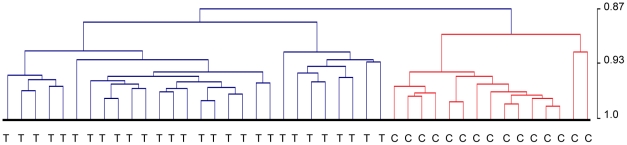
Dendogram from unsupervised hierarchical clustering.Including the 43 samples selected for differential gene expression analysis and all 12579 genes detected in these samples. Control samples are denoted by C and tumours by T. Pearson correlation was used as a measurement of similarity.